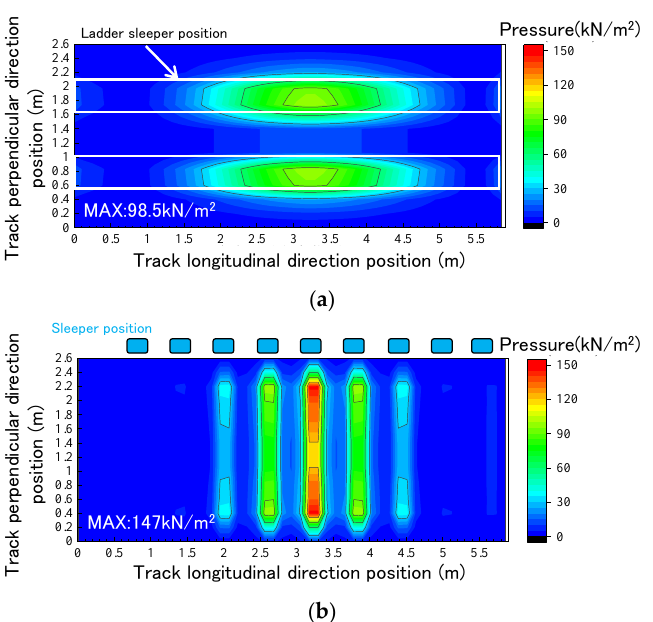
Figure 15. Pressure on sleeper bottom plane (CASE1): ( a ) ladder track; ( b ) PC sleeper.